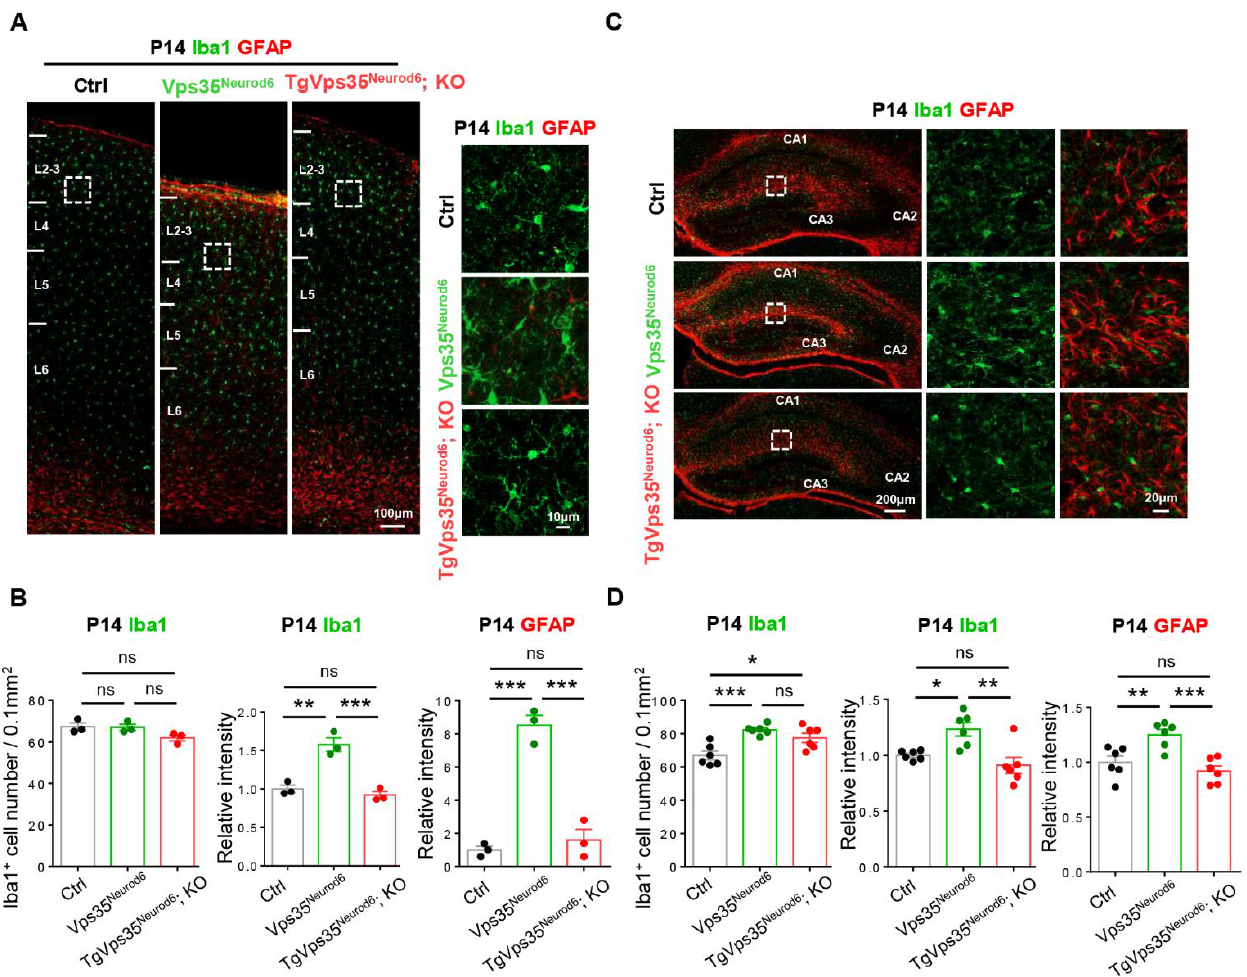
Figure 3. Vps35-mCherry expression rescues glial activation of Vps35 Neurod6 pups at P14. ( A , C ) Representative images of immunostaining analysis using indicated antibodies in P14 neocortical and hippocampal sections from mice with labelled genotype. Higher-magnification images of the boxed regions were shown in offside panels. ( B , D ) Quantification of immunofluorescence from A,C. (For A,B: n = 3 animals per genotype; for C,D: n = 6 views from three animals per genotype; one-way ANOVA with Tukey’s multiple-comparison test). Scale bars as indicated in each panel. Individual data points were shown as dots with group mean ± S.E.M; * p < 0.05; ** p < 0.01; *** p < 0.001; n.s.: Not significant.